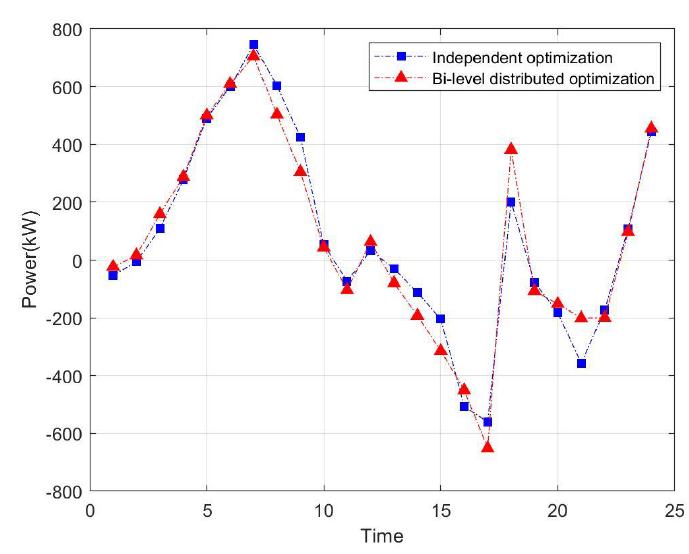
Figure 9. Result of two optimization methods of VMG2.